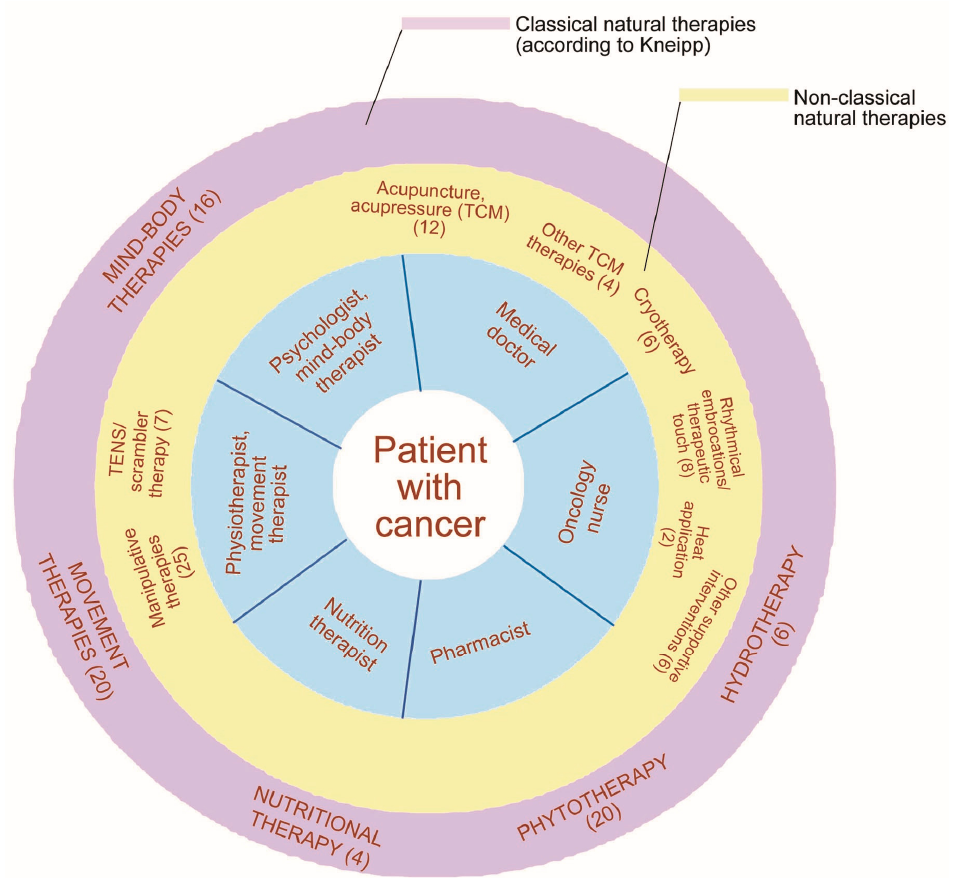
Figure 3. Interprofessional CIPN symptom management. Legend. Number in brackets refer to external study evidence and results of the consensus process (Tables S1, S2 and S5).